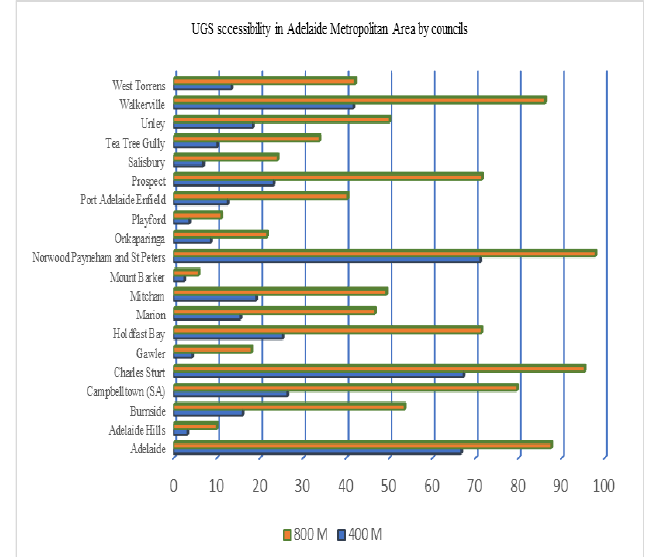
Figure 3. Walkable accessibility to UGS in Adelaide Metropolitan Area by